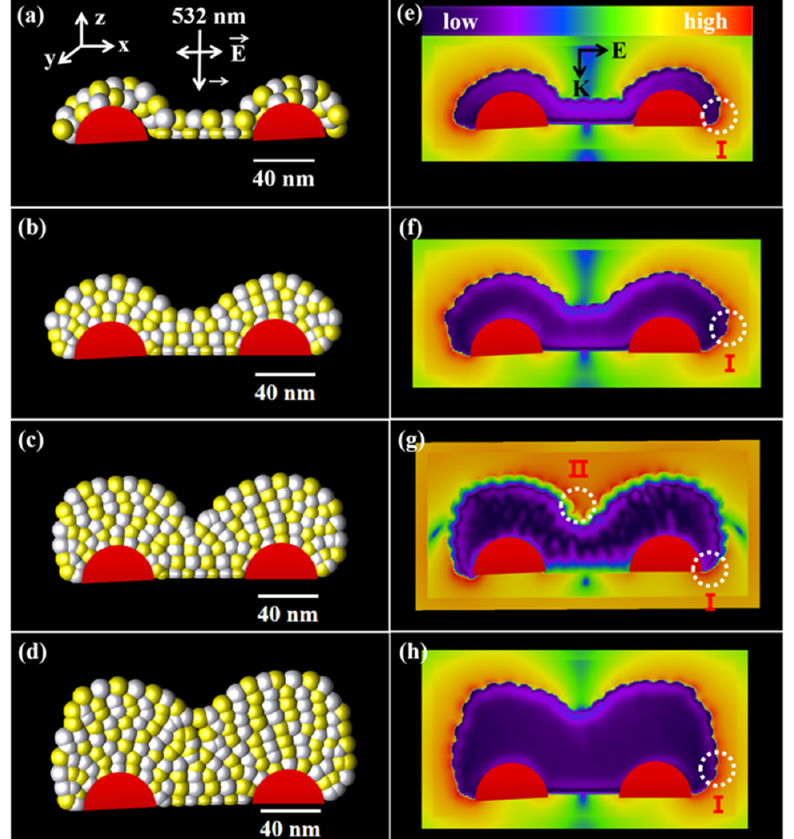
Figure 7. ( a – d ) Three ‐ dimensional FDTD models of AgCu@MW substrates with different co ‐ sput ‐ tering times. ( e – h ) The electric near ‐ field intensity maps for the x–z plane around the corresponding substrates in a – d .